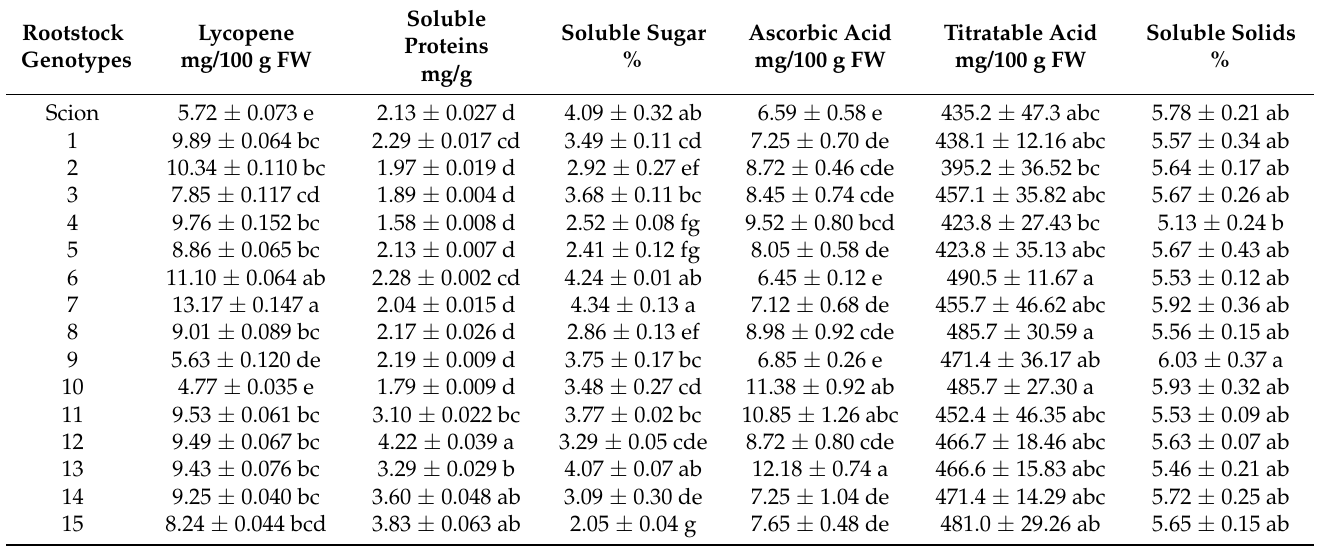
Table 5. Fruit quality of grafted tomatoes with the 15 rootstock genotypes under greenhouse